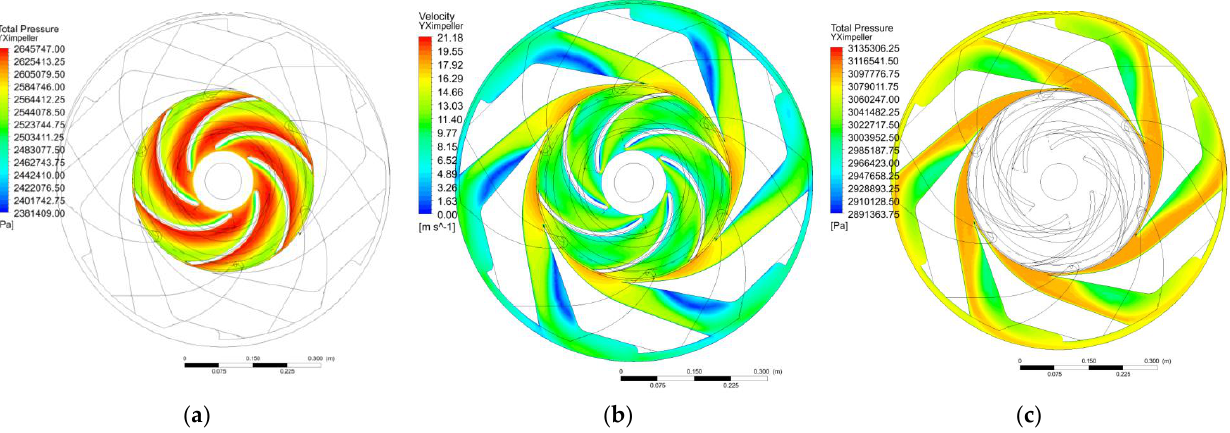
Figure 4. Characteristics of the pump flowing part: ( a ) pressure distribution in the intervane chan- nels of the impeller; ( b ) a qualitative picture of the relative velocity distribution in the diffuser chan- nel of the outlet device; ( c ) a qualitative picture of the pressure distribution in the diffuser channel of the outlet device.